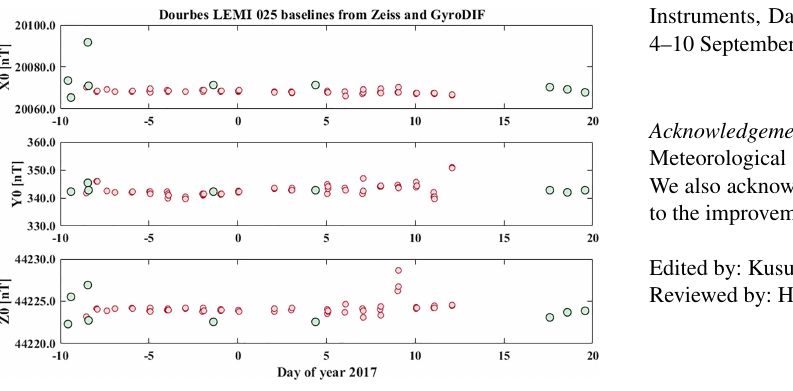
Figure 9. Blue: Dourbes LEMI 025 baselines computed from Gy- roDIF measurements (red). The true north direction used in the Y 0 baseline is determined by means of hybrid method. The green dots are computed from conventional DI-flux